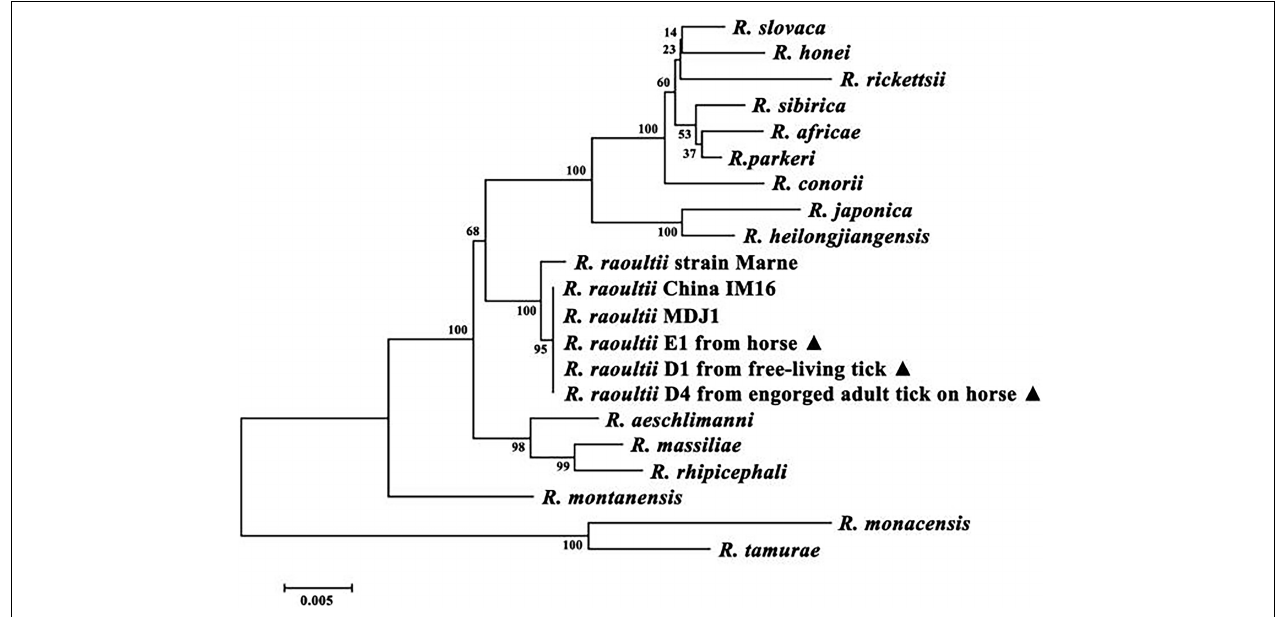
FIGURE 1 | Molecular phylogenetic analysis of Rickettsia raoultii isolates from horse. Two genes were concatenated ( glt A + omp A), a total of (1,047 + 498) positions were tested. GenBank accession numbers of the Sequences of the Rickettsia species used to make the concatenated analysis were as follows: R. rickettsii (U59729 + U43804), R. slovaca (U59725 + U43808), R. massiliae (U59719 + U43799), R. africae (U59733 + U43790), R. honei (U59726 + U43809), R. conorii (U59730 + U43806), R. japonica (U59724 + U43795), R. montanensis (U74756 + U43801), R. aeschlimanni (U59722 + U43800), R. heilongjiangensis (AF172943 + AF179364), R. parkeri (KY124257 + KY271186), R. rhipicephali (DQ865206 + DQ865208), R. monacensis (LN794217), R. sibirica (DQ097081 + DQ097082), R. tamurae (AF394896 + DQ103259), R. raoultii China IM16 (KY474576 + KY474577), R. raoultii strain Khabarovsk (DQ365804 + AH015610), R. raoultii strain Marne (DQ365803 + AH015609), R. raoultii D1 from free-living tick (MH212179 + MH212186), R. raoultii E1 from horse (MH212183 + MH212190) and R. raoultii D4 from engorged adult tick on horse (MH212181 + MH212188).